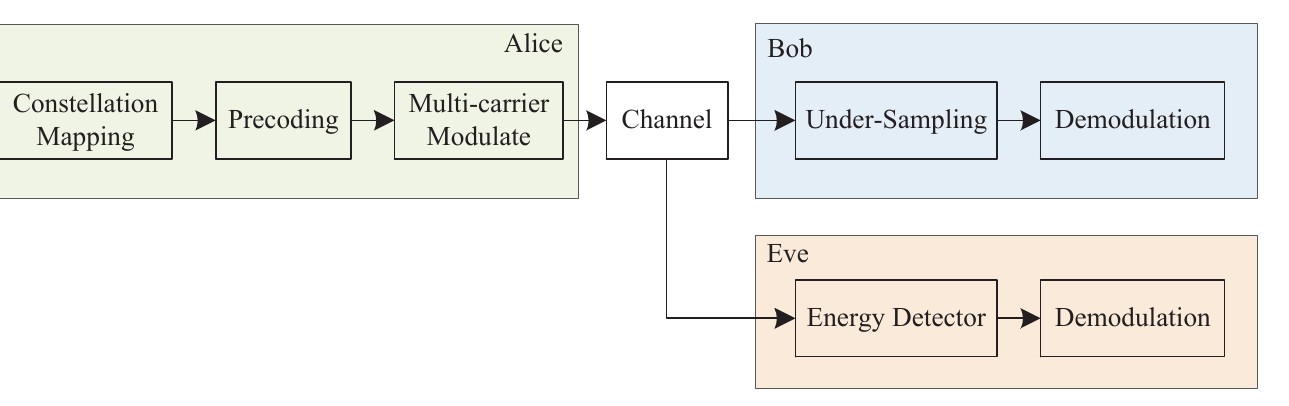
Figure 6. Diagram of the system model in simulations.